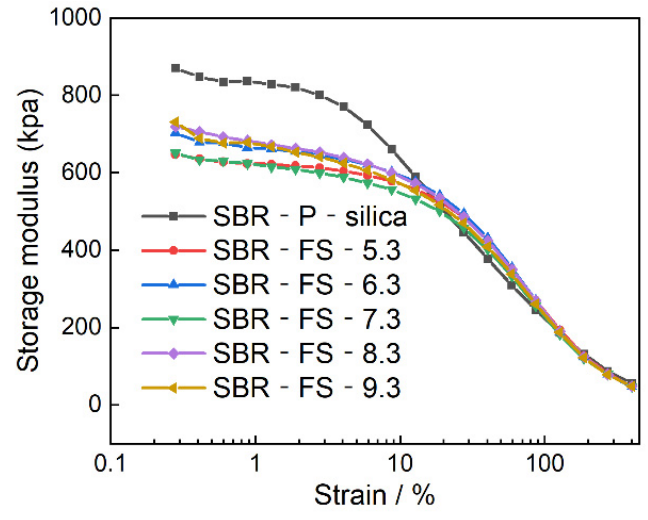
Figure 10. RPA strain sweep of SBR composites filled with P-silica and FS-SiO 2 . Table 5. The delta storage modulus ( Δ G’) of SBR composites filled with P-silica and FS-SiO 2 .